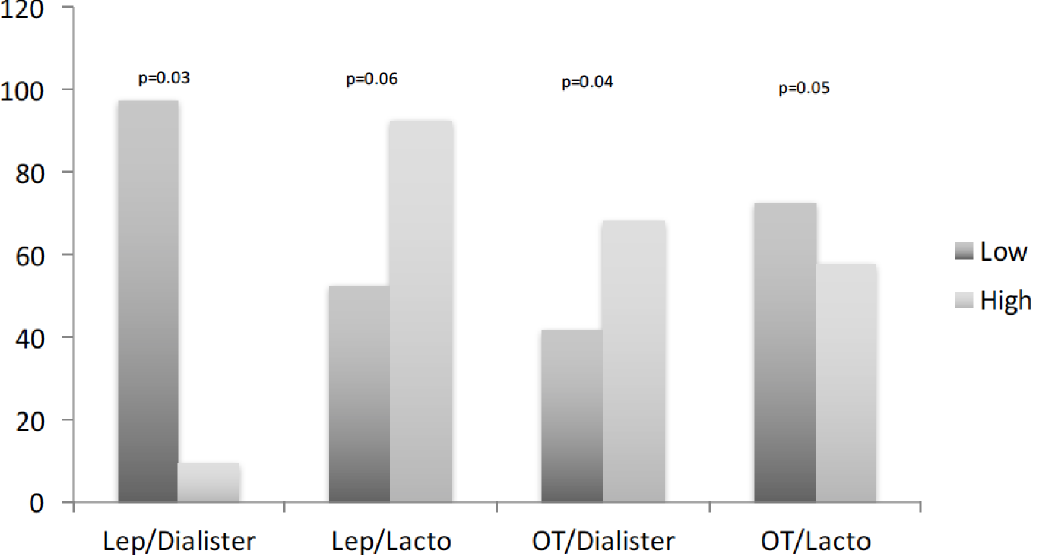
Fig 7. Taxa abundance based on circulating leptin and oxytocin. Data are relative counts for taxa abundance of genus Dialister and order Lactobacillales (Lacto) in subjects without diabetes. The subjects were divided based on low (Low) or high (High) level of Leptin (Lep) and oxytocin (OT). Pairwise Mann-Whitney test was used to compare the groups. There was lower abundance of Dialister in High-Leptin vs. Low-Leptin (p = 0.03), but higher abundance of Dialister in High-Oxytocin vs. Low-Oxytocin (p = 0.04). The opposite trends were observed for the order Lactobacillales, a higher abundance in High-Leptin vs. Low-Leptin (p = 0.06) and vice versa for oxytocin (p =